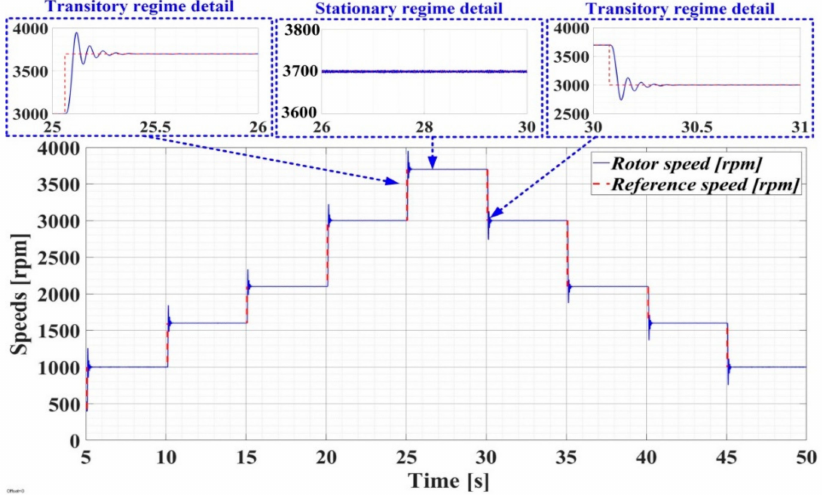
Figure 24. Real-time speed evolution of PMSM–CS–CI based on the PI-type